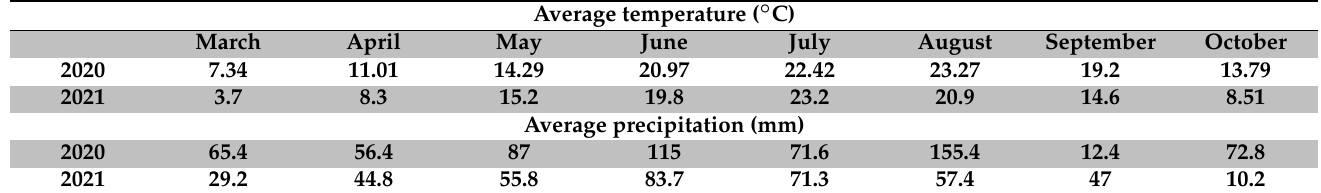
Table 1. Mean monthly values of precipitations and temperatures at the experimental